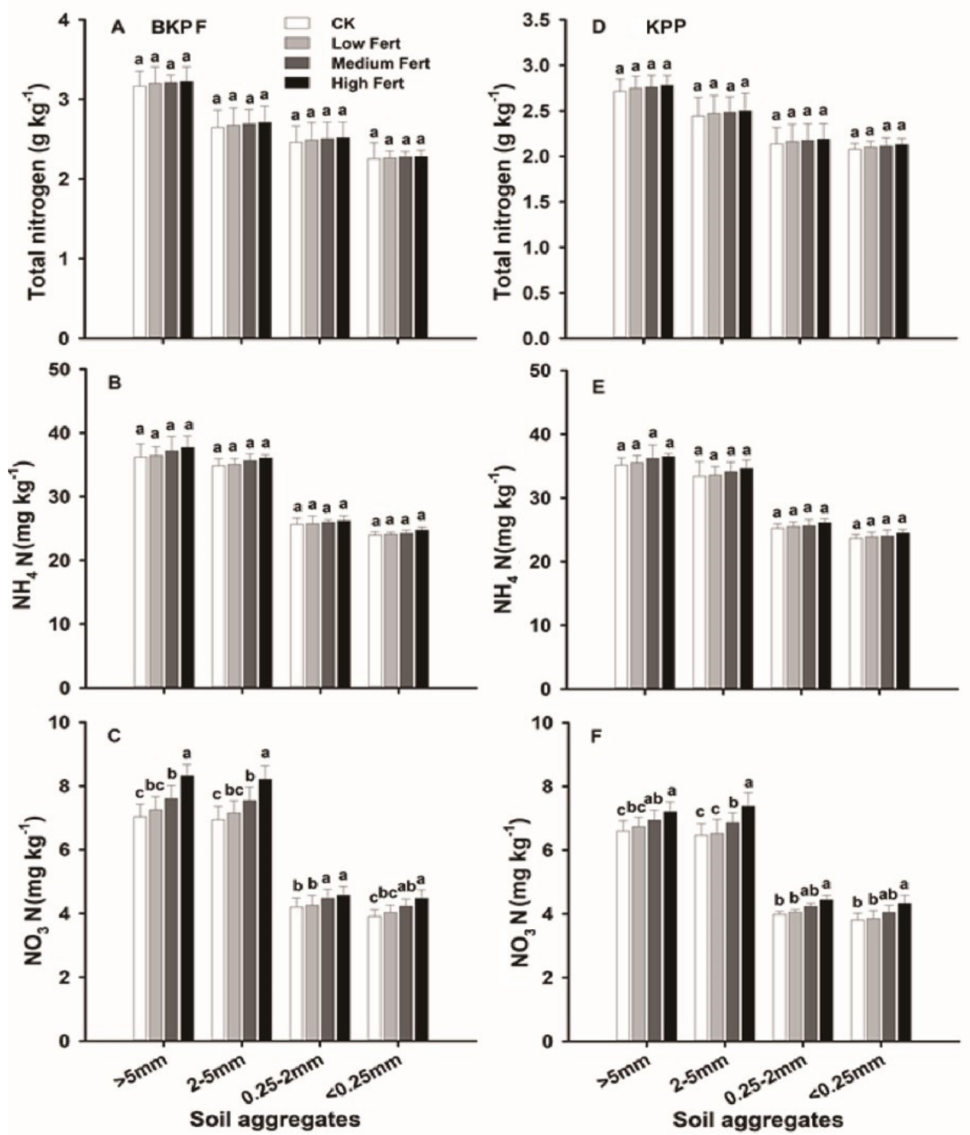
Figure 3. Total nitrogen ( A , D ), NH 4 -N (mg kg − 1 )( B , E ), and NO 3 -N (mg kg − 1 ) ( C , F ) at the con- trol (C: no additional deposition; white bars) and after low NP: 05-g N m − 2 a − 1 + 05-g N m − 2 a − 1 ; light grey, medium NP: 15-g N m − 2 a − 1 + 10-g N m − 2 a − 1 ; dark grey, and high NP: 30-g N m − 2 a − 1 + 20-g N m − 2 a − 1 ; black fertilization in respective soil aggregates >5 mm, 2–5 mm, 0.25–2 mm, and <0.25 in three replications at 0–20 cm soil depth of mixed broad-leaved Korean pine forest (BKPF) and artificial Korean pine forest (KPP) in Northeast (NE) China. Significant differences between treatments are indicated by different lower-case letters (Tukey’s HSD post hoc; p <